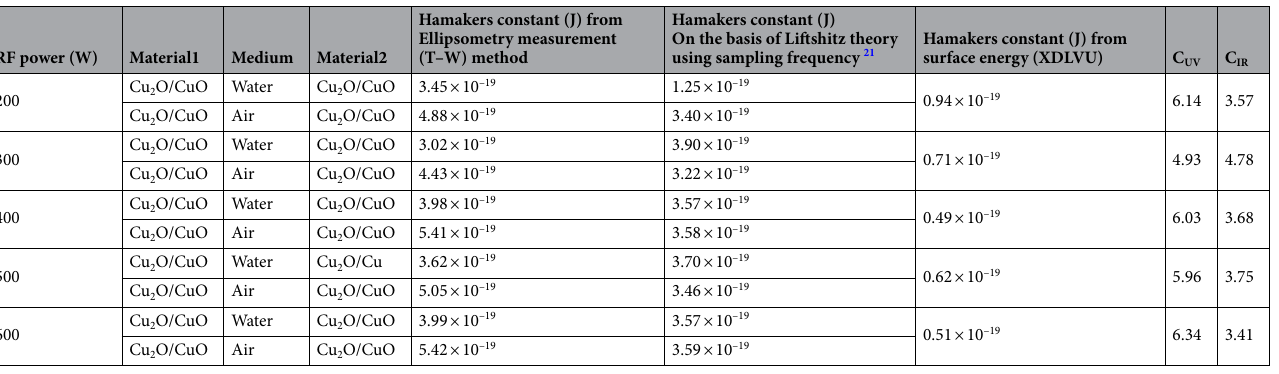
Table 8. Table of non retarded Hamaker constants evaluated from ellipsometry and surface energy